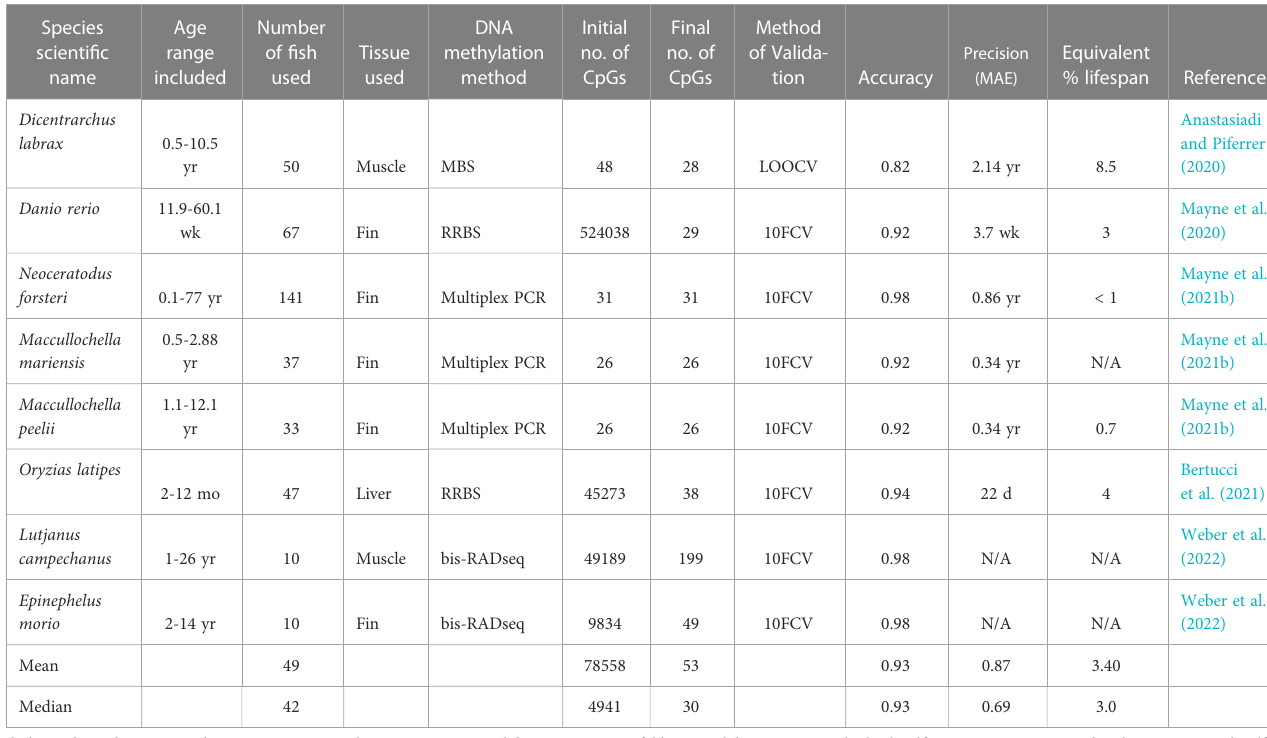
TABLE 1 Characteristics and performance of piscine epigenetic